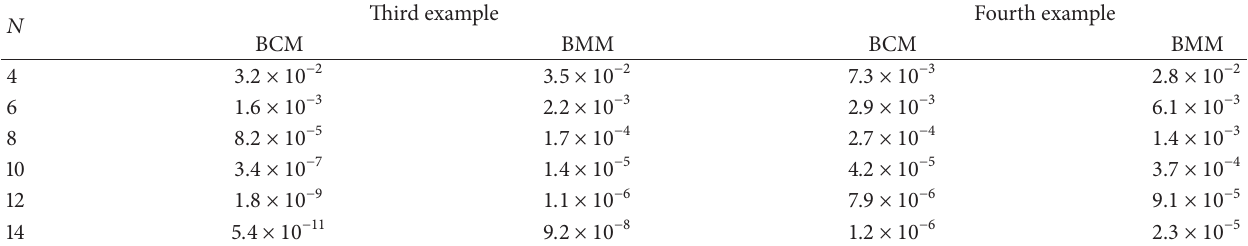
Table 2: Comparisons of the BCM and BMM associated with the errors 𝐸 𝑁 in the third and fourth example. 𝑁